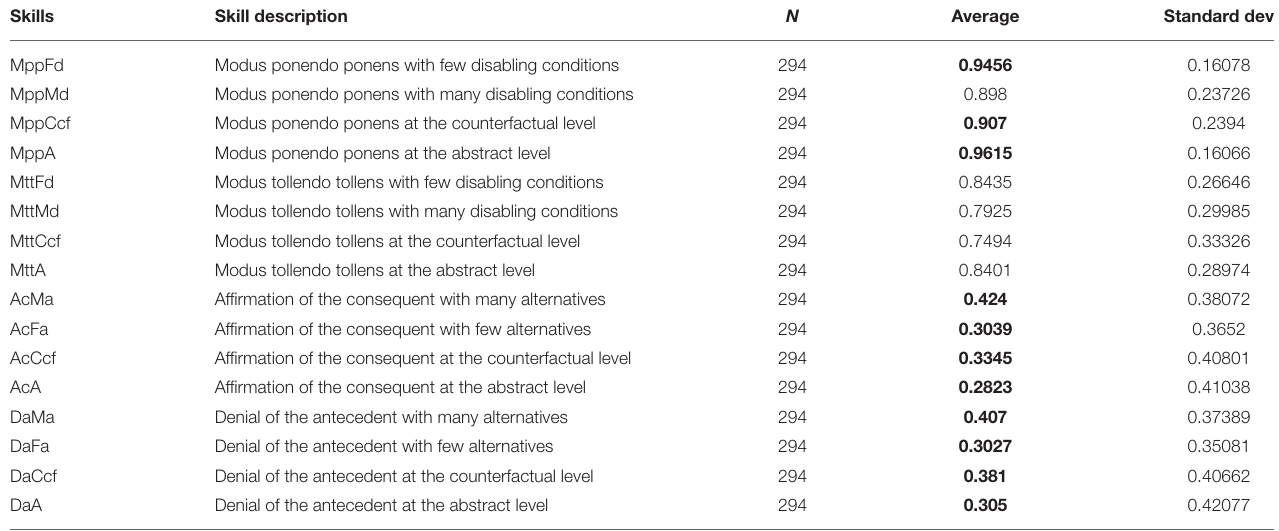
TABLE 1 | Distribution of responses over